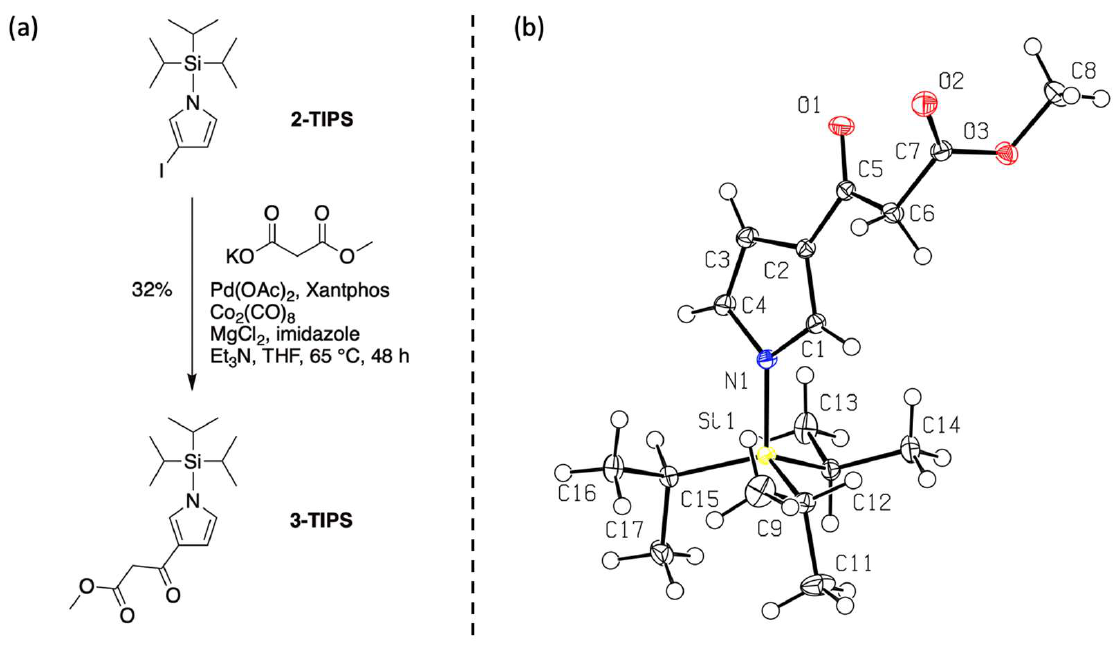
Figure 2. Installation of the β-ketoester ( a ) and ORTEP diagram of 3-TIPS with thermal ellipsoids drawn at the 50% probability level ( b ).